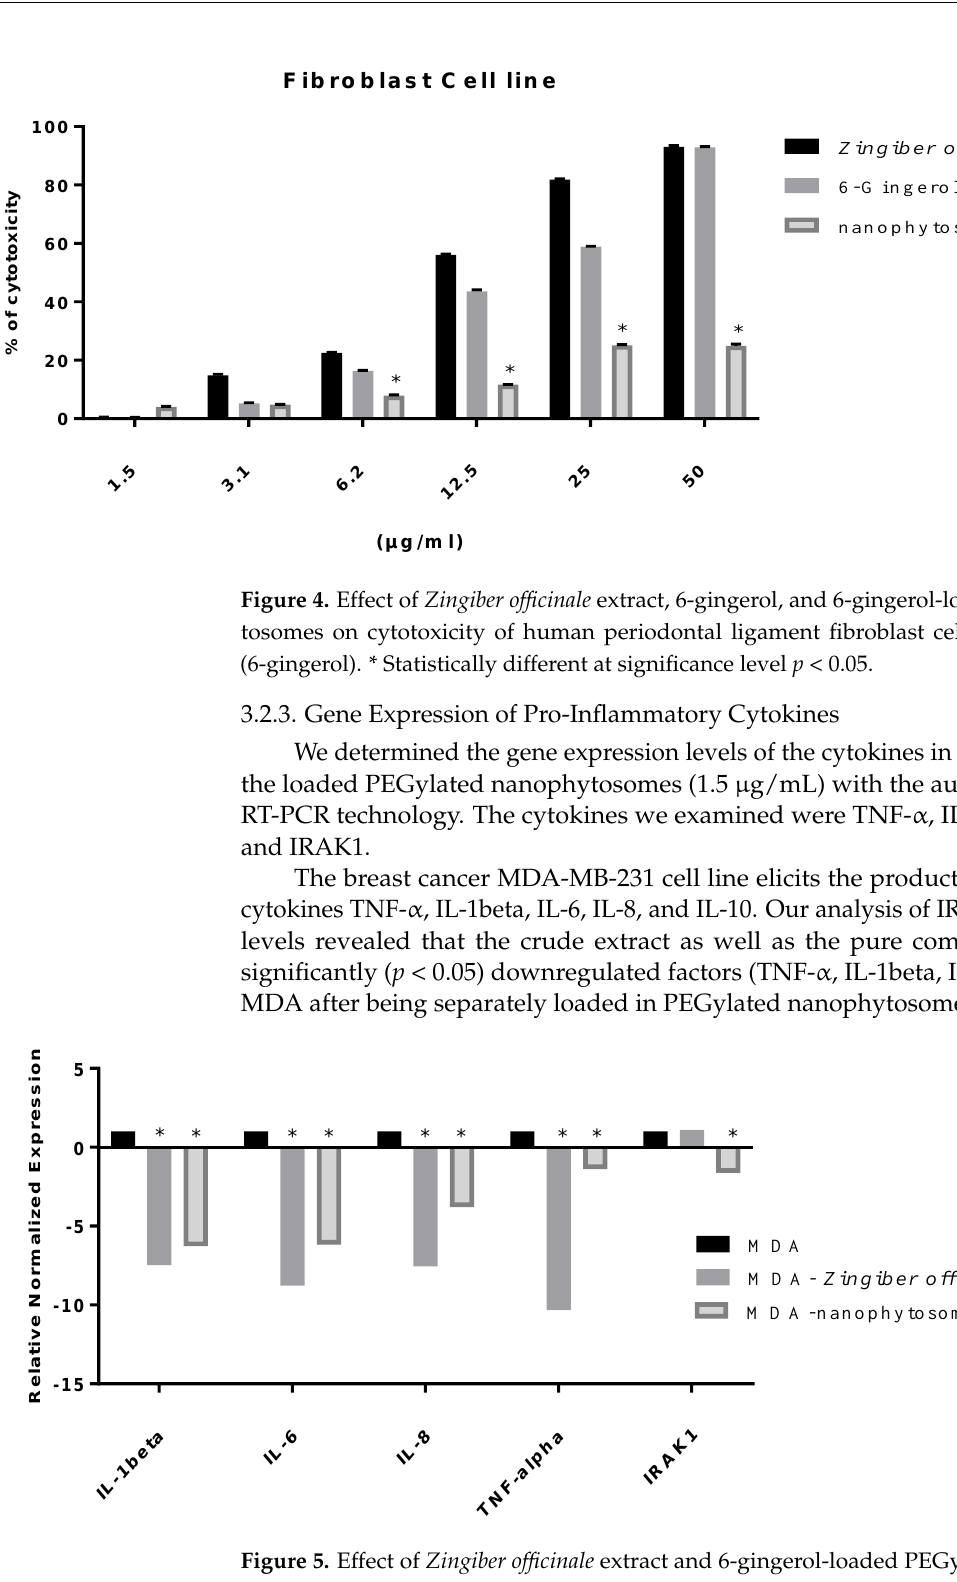
Figure 3. Effect of Zingiber officinale extract, 6-gingerol, and 6-gingerol-loaded PEGylated nanophy- tosomes on cytotoxicity of Panc1 cells compared with control (6-gingerol). * Statistically different at significance level p < 0.05.